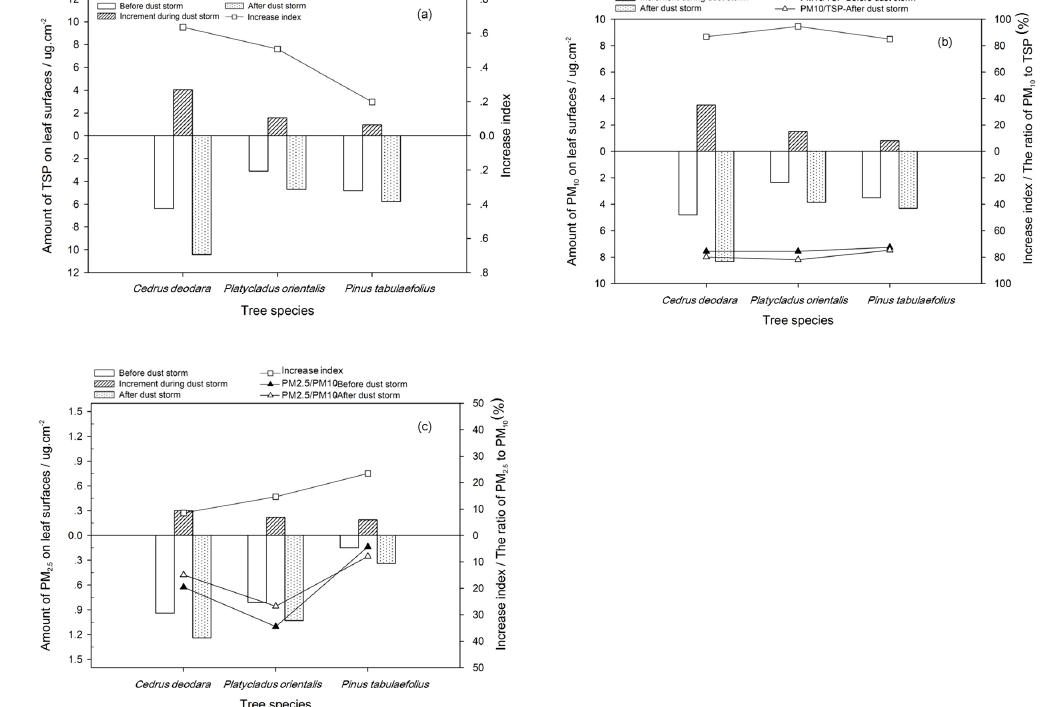
Figure 12. TSP ( a ), PM 10 ( b ), and PM 2.5 ( c ) on the leaf surfaces of the evergreen tree species before and after dust storm and its increase